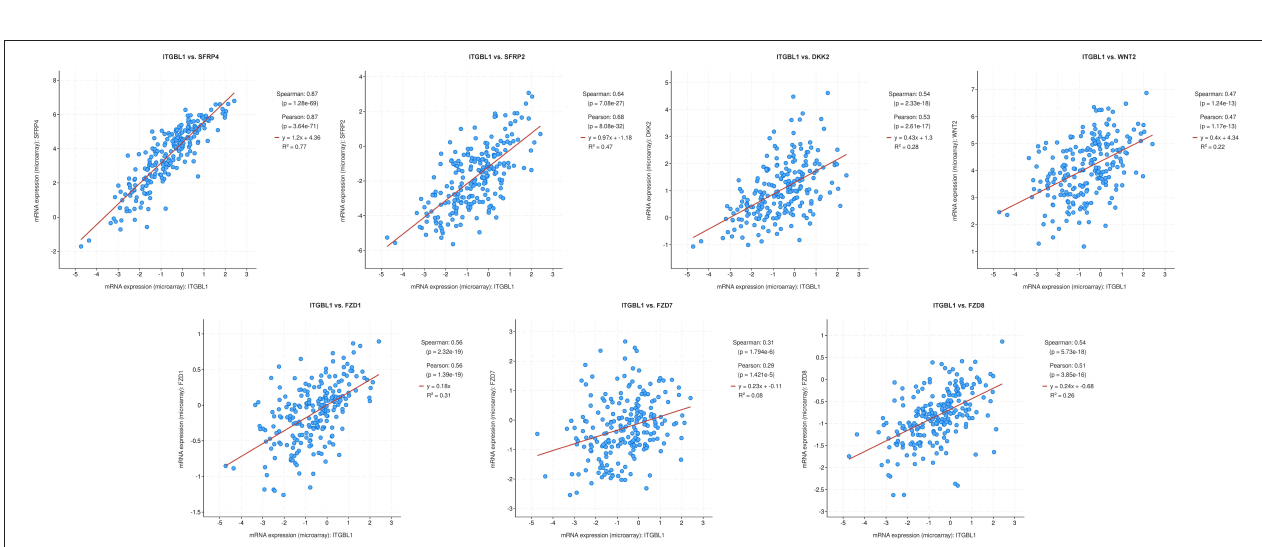
FIGURE 2 | Co-expression relationship of ITGBL1 and seven extracellular Wnt signals. Y axis in this figure represented mRNA relative expressions of these seven extracellular Wnt signals, and X axis represented mRNA relative expressions of ITGBL1. The red line indicated regression line.